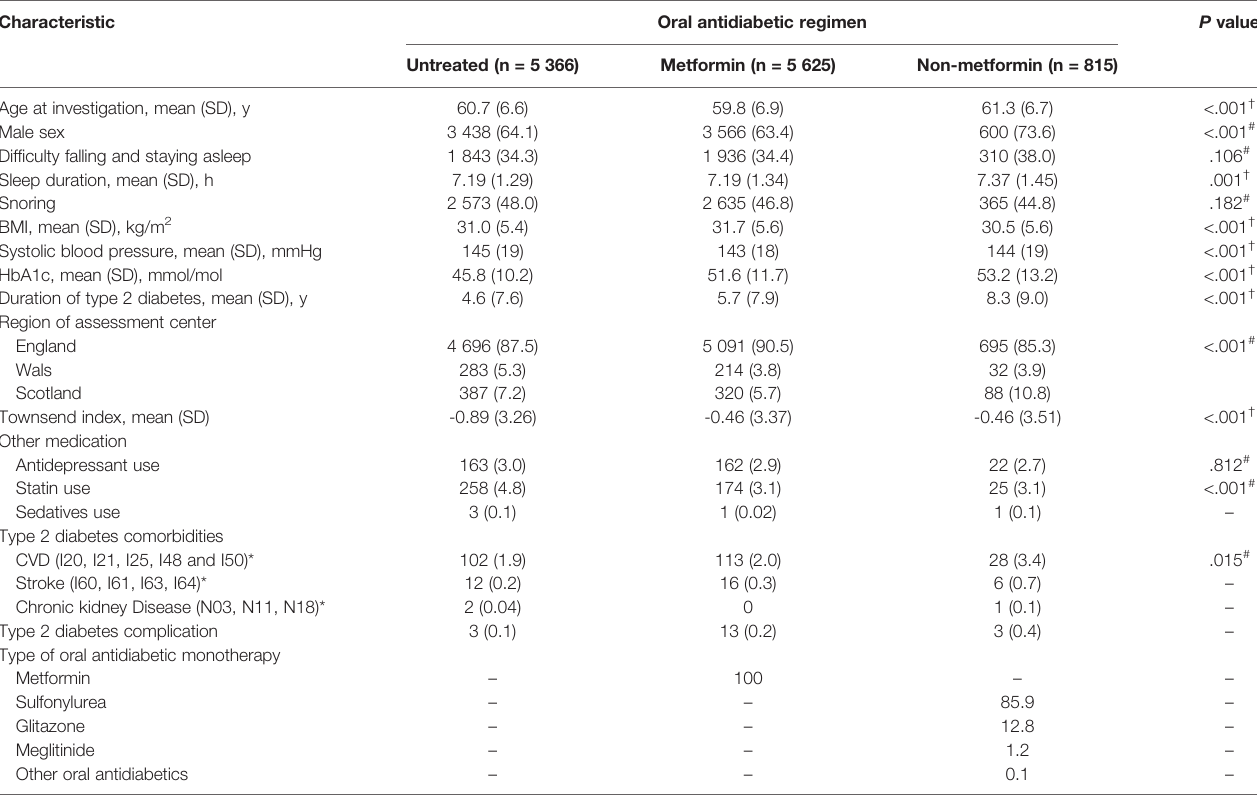
TABLE 2 | Baseline characteristics of untreated, metformin, and non-metformin patients with type 2 diabetes.